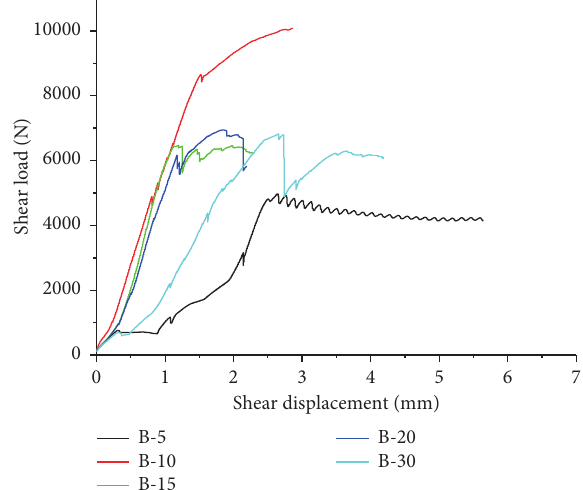
Figure 6: Shear mechanical properties of different undulating height models.